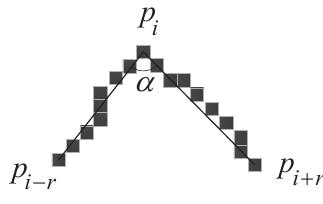
Figure 2. The support angle of point on